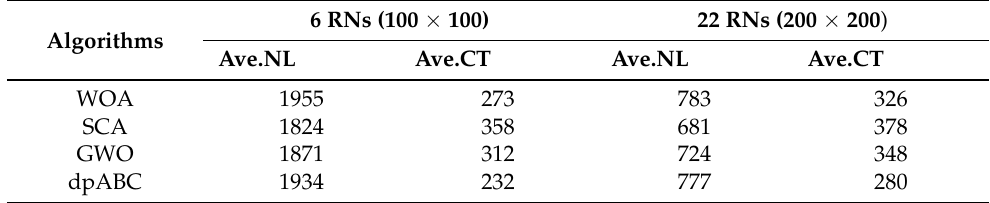
Table 2. TT-WSN lifetime optimization for different algorithms.